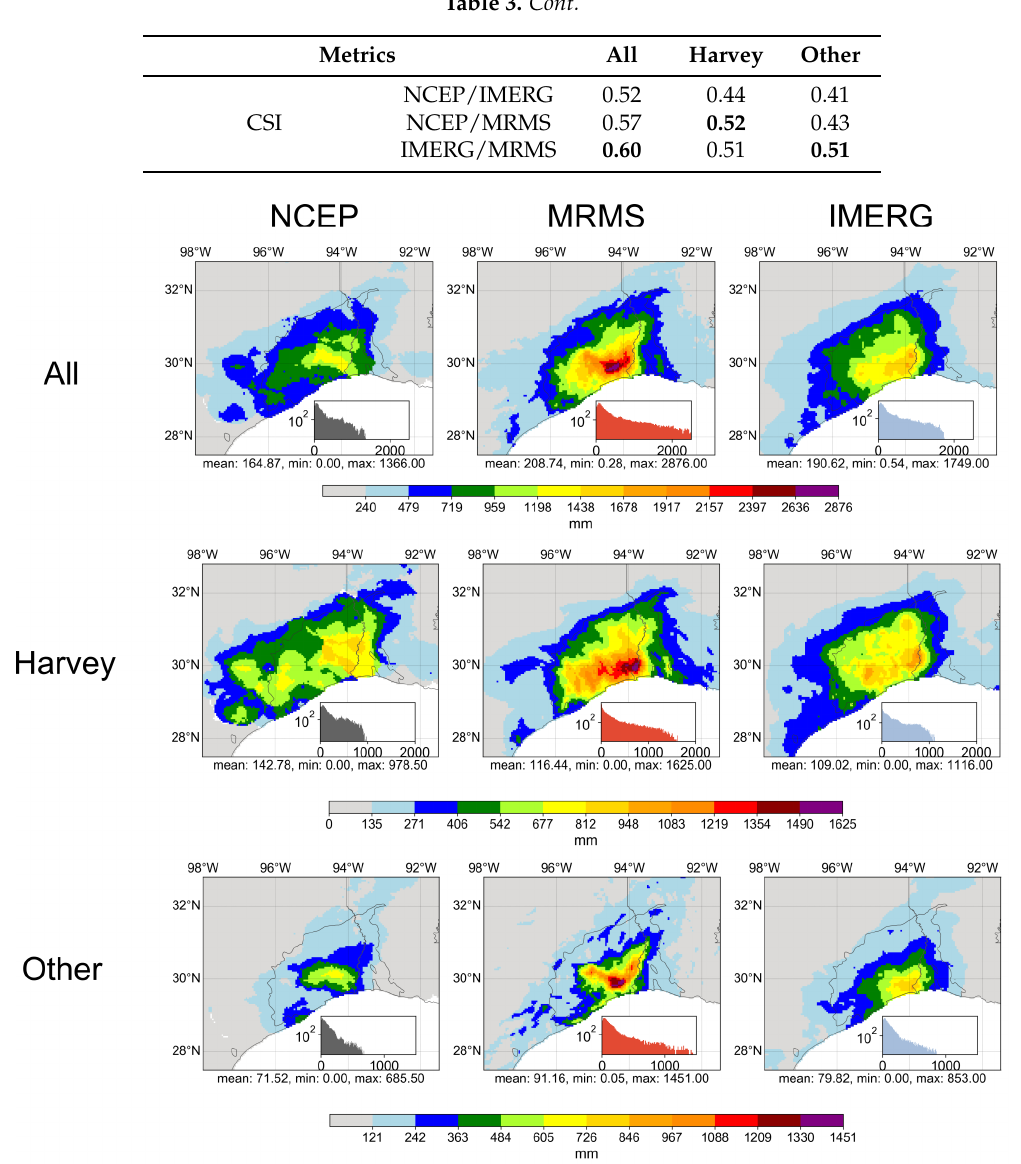
Figure 2. Accumulative rainfall observed in three cases. Inside each axes, the inset corresponds to the histogram of accumulative